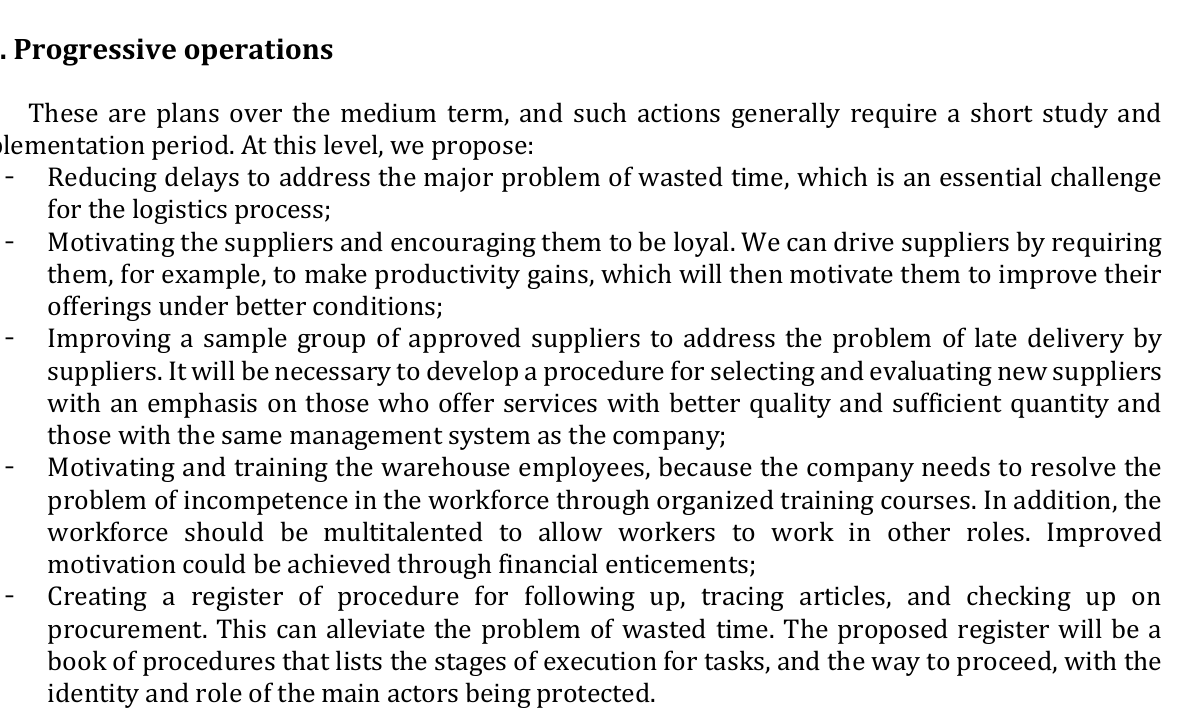
Table 2: Practical model of the daily card to follow up all the scanners Scanner’s Name of the number store man Sc P. 03 Xsavier Vittori 13-02-2011-